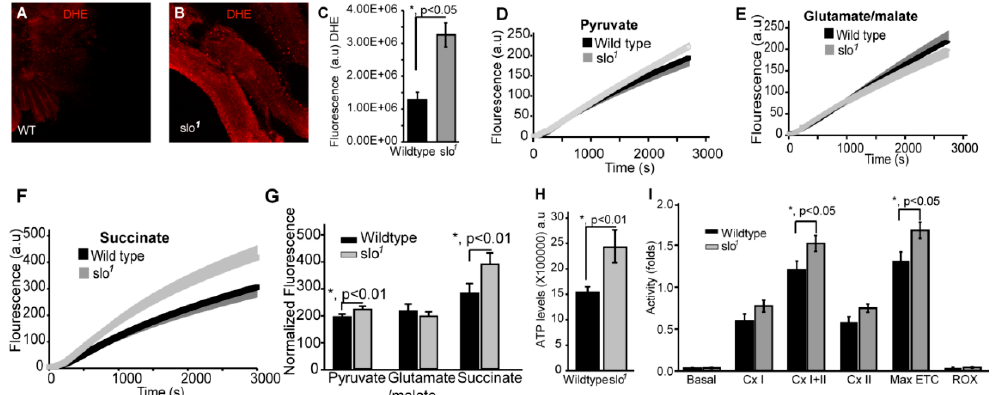
Figure 2. Mitochondrial functional defects in slo 1 mutants. ( A ) (wt) and ( B ) ( slo 1 ) show indirect flight muscles stained with DHE to detect ROS. ( C ) Quantification of ROS fluorescence in A and B (wt ‐ black, slo 1 ‐ grey). The graphs in ( D – F ) show ROS generation in isolated wt (black) and slo 1 mutant mitochondria (gray) in the presence of pyruvate ( D ), glutamate/malate ( E ), or succinate ( F ) as substrates. Succinate and pyruvate, but not glutamate/malate show an increase in ROS as detected by the amplex red dye, compared to wt mitochondria. ( G ) Quantification of ( D) , ( E ) , and ( F ). ( H ) shows ATP levels increased in slo 1 mutants (wt ‐ black, slo 1 ‐ grey). ( I ) Quantification of oxygen flux from enriched mitochondria from 40 thoraces of wt (black) and slo 1 mutants (gray) flies. Basal, complex I, complex II, and ROX (non ‐ mitochondrial residual oxygen consumption rate) oxygen consumption rates do not significantly vary between wt and slo 1 mutants but combined complex I and complex II and maximum ETC consumption are significantly higher in slo 1 mutants.